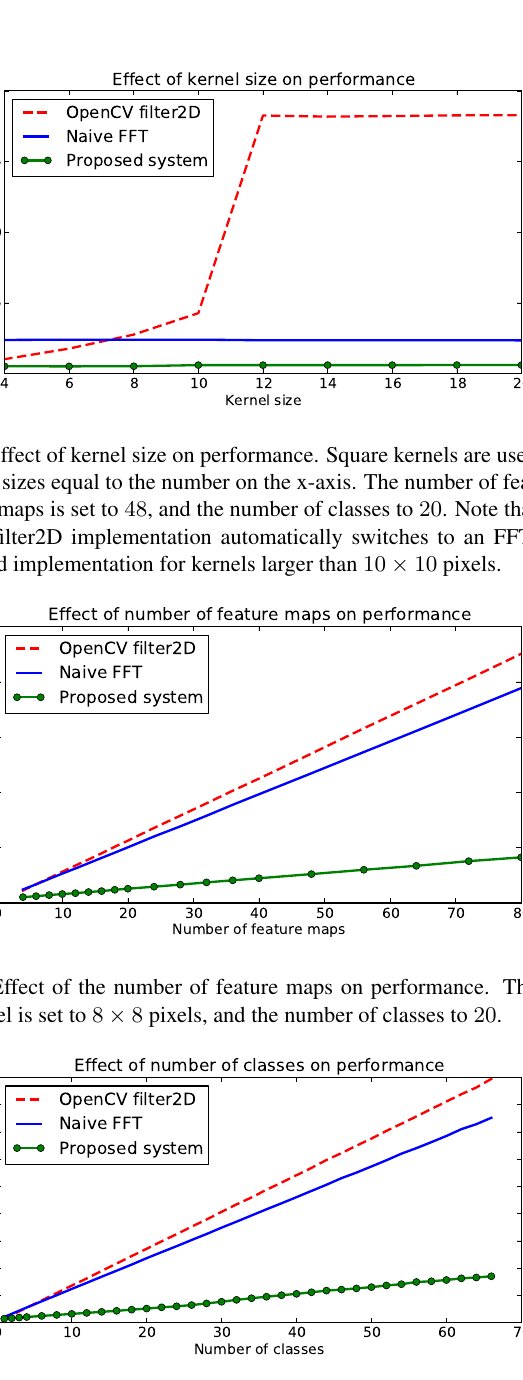
(c) Effect of the number of classes on performance. The kernel size is set to 8 × 8 , and the number of feature maps to 48 . Figure 4: Experimental results of our benchmarks. Experiments are performed on a Windows-7 PC with a CPU Core i7 920, single-threaded. Processing times are in seconds, for feature maps of 600 × 300